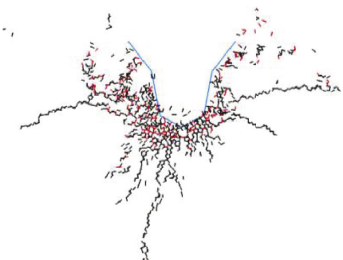
Figure 5: Failure characteristics of rock mass in the process of rock breaking by disc